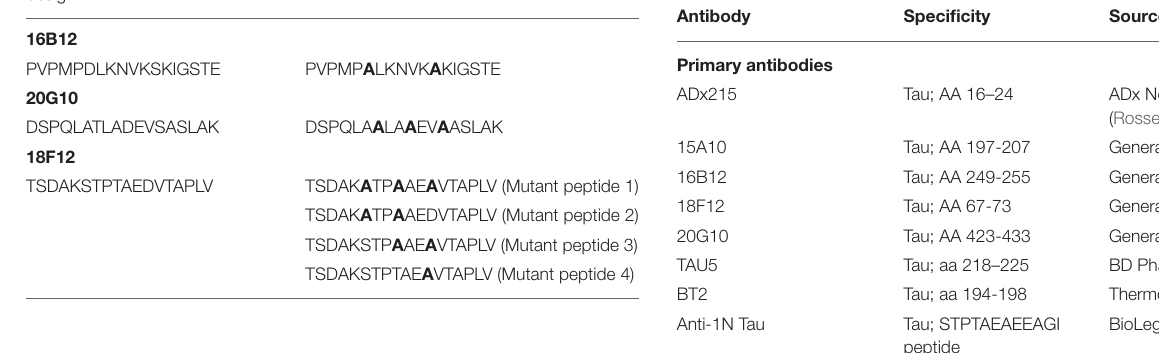
TABLE 3 | Antibodies used in these